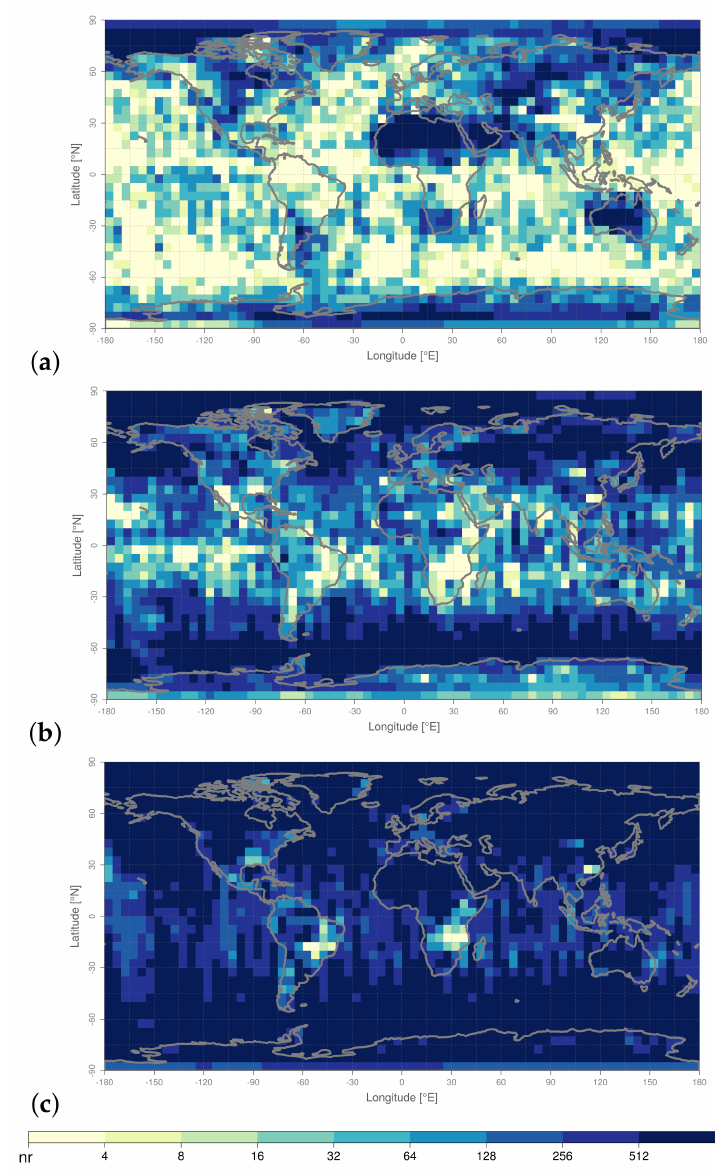
Figure 3. Sampling number of matched NTB pairs with strict matching criteria for ( a ) clear, ( b ) overcast, and ( c ) all-sky conditions in 5 ◦ × 5 ◦